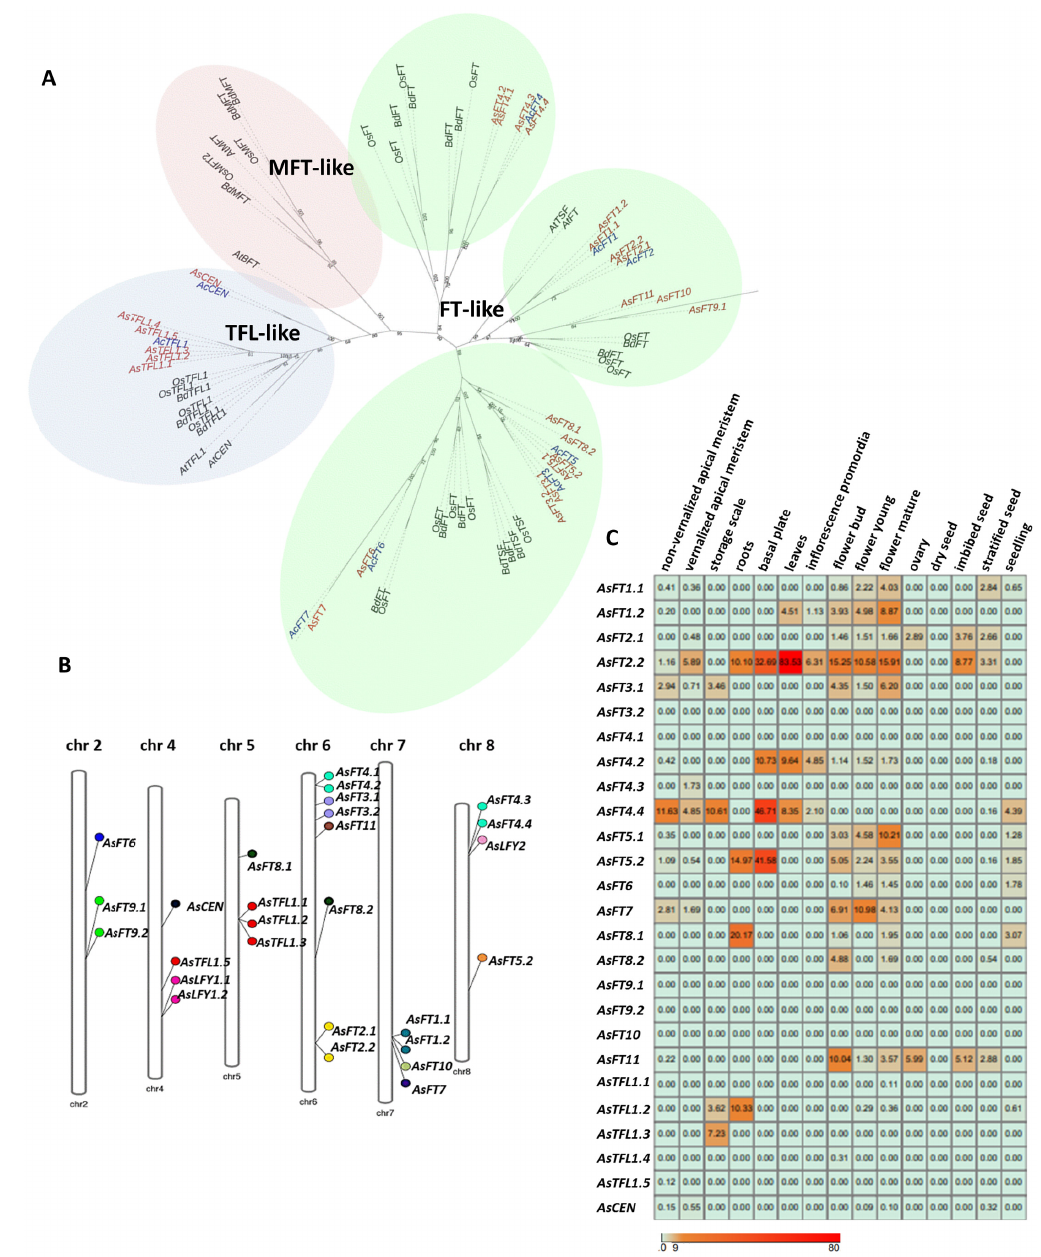
Figure 1. Genomic and transcriptome analyses of PEBP genes in fertile seed-producing garlic genotype. ( A ) Interspecific phylogenetic tree of PEBP proteins from various species: Arabidopsis ( Arabidopsis thaliana, At), onion ( Allium cepa , Ac), rice ( Oryza sativa , Os), Brachypodium ( Brachypodium distachyon , Bd), and garlic ( Allium sativum , As). Alignment was performed using the MAFFT program and RAxML-NG to generate an unrooted ML radial tree constructed with 100 bootstrap replica- tions. iTOL [51] was used for tree presentation. The background colors highlight the groups of FT-like, TFL1/CEN-like, and MFT-like proteins. Red font, garlic genes; blue font, onion genes. ( B ) Chromosomal localization of PEBP and LFY genes of Allium sativum . The relative sizes represent the length of the garlic chromosomes. Lines connect colored circles to the corresponding base-pair location of each gene. ( C ) Tissue-specific expression patterns of garlic PEBP genes in vegetative and reproductive organs and seeds. The expression values were computed as FPKM based on transcrip- tome analyses of vegetative and reproductive organs and seeds [11,12,19,52]. FPKM values were used to create a heat map by one minus Pearson correlation, with MORPHEUS [53]. Color scale on heat map ranges from red (high value) to green (low